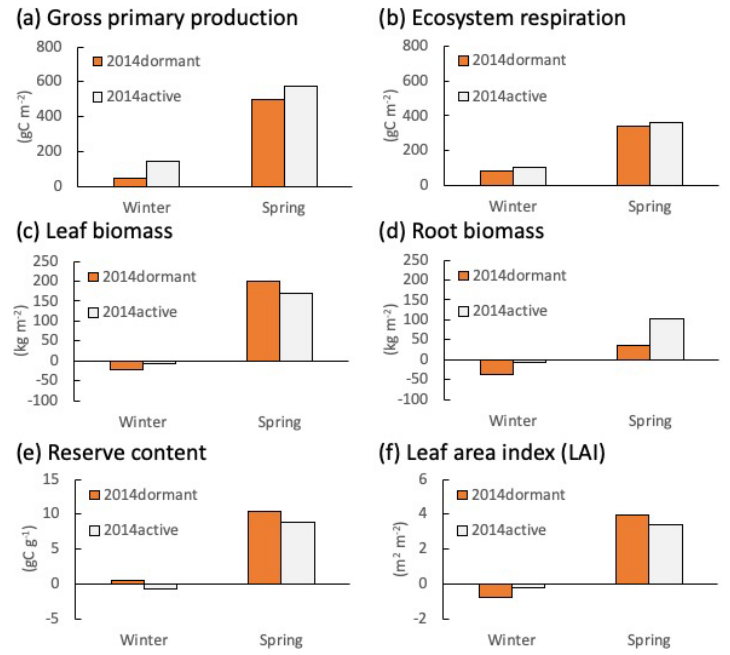
Figure 5. Changes in calculated (a) gross primary production (GPP), (b) ecosystem respiration, (c) live leaf and (d) root biomasses, (e) re- serve content, and (f) leaf area index (LAI) at Fendt during the winter (from December to February) and spring (from March to May) in 2014 in active (grey bars) and dormant cases (orange bars).